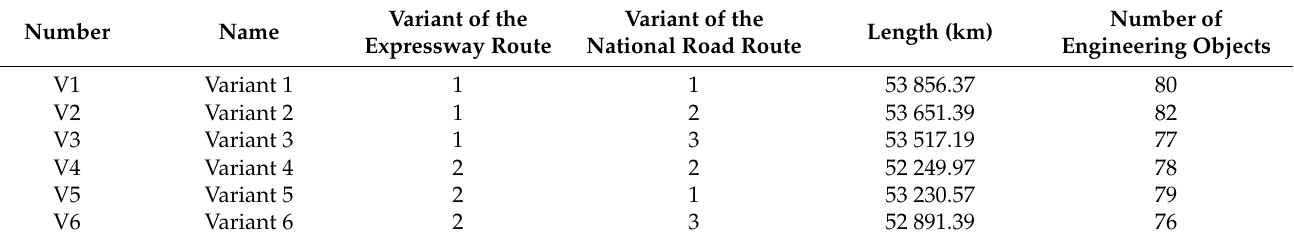
Table 3. Variants’